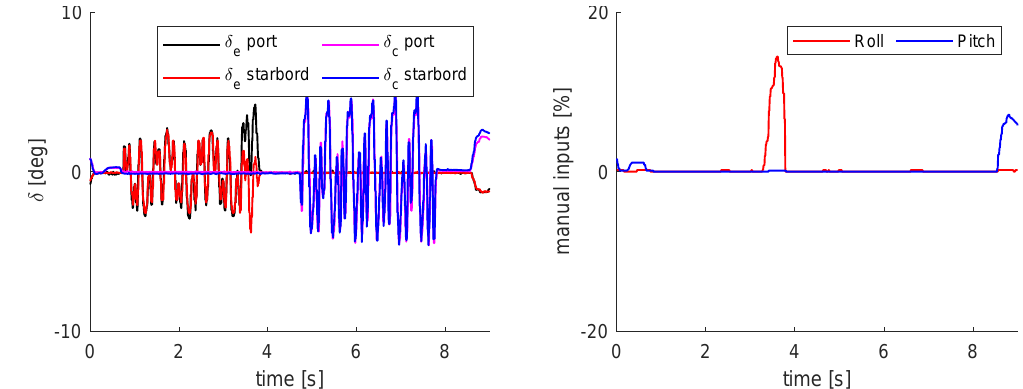
Figure 19. Flight test data showing a sudden roll correction commanded by the pilot during manoeuvre MSs2 in Flight FT. #2. This disturbance may explain the poor fit obtained for this